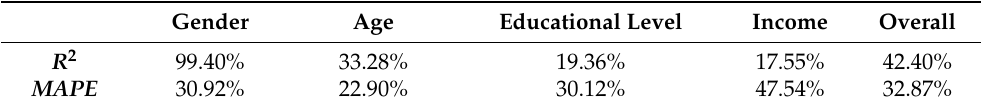
Table 5. Adjustment of the ANN